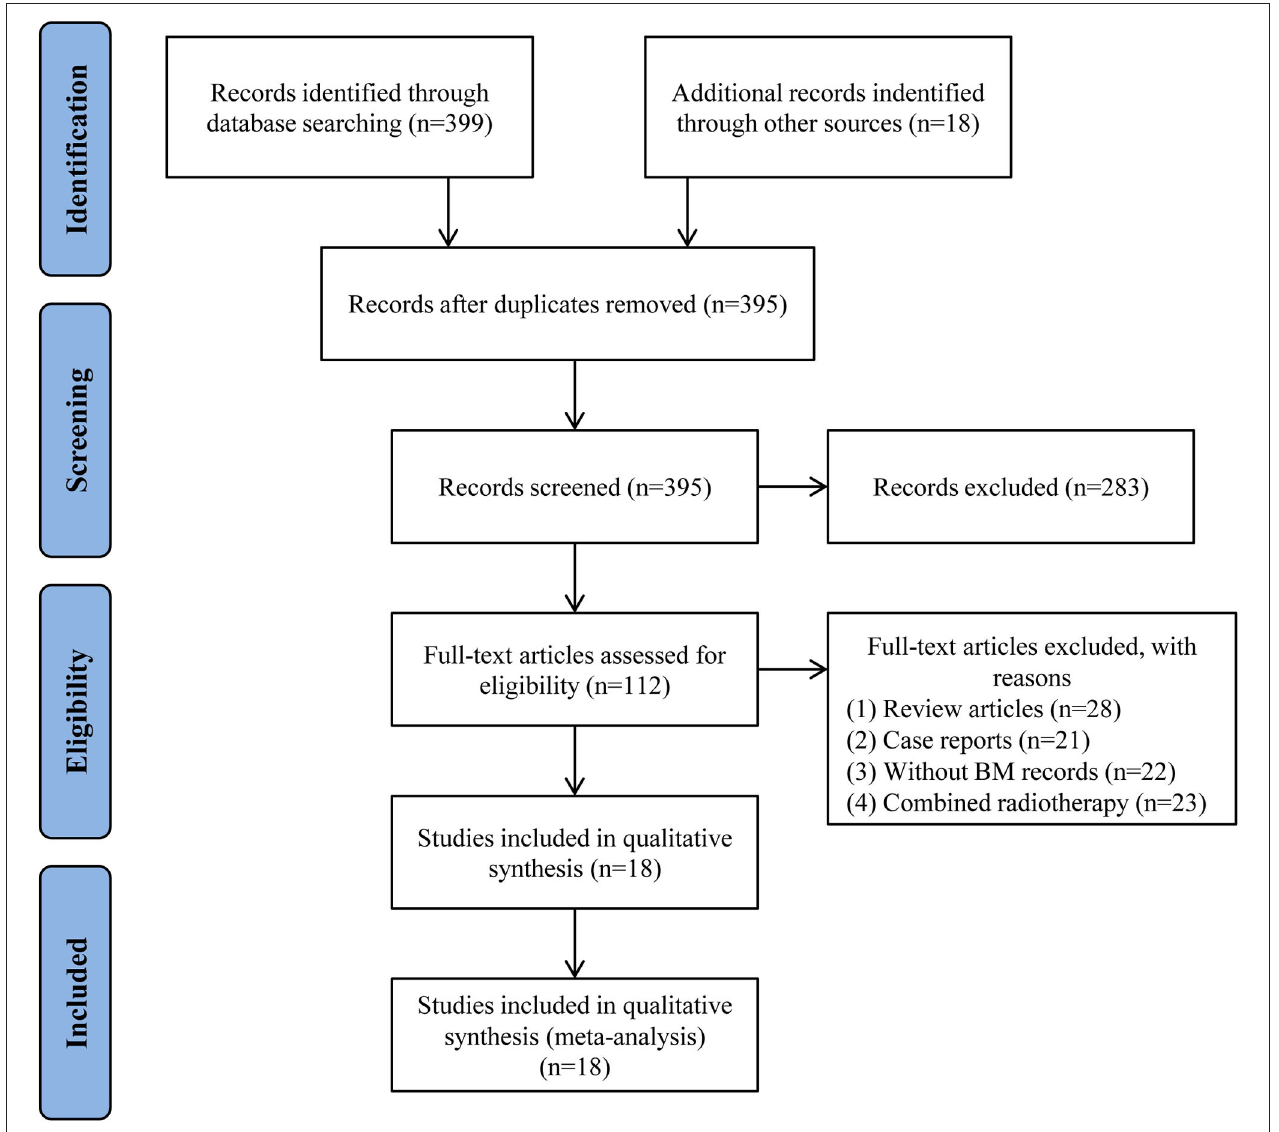
FIGURE 1 | Flow chart of study selection